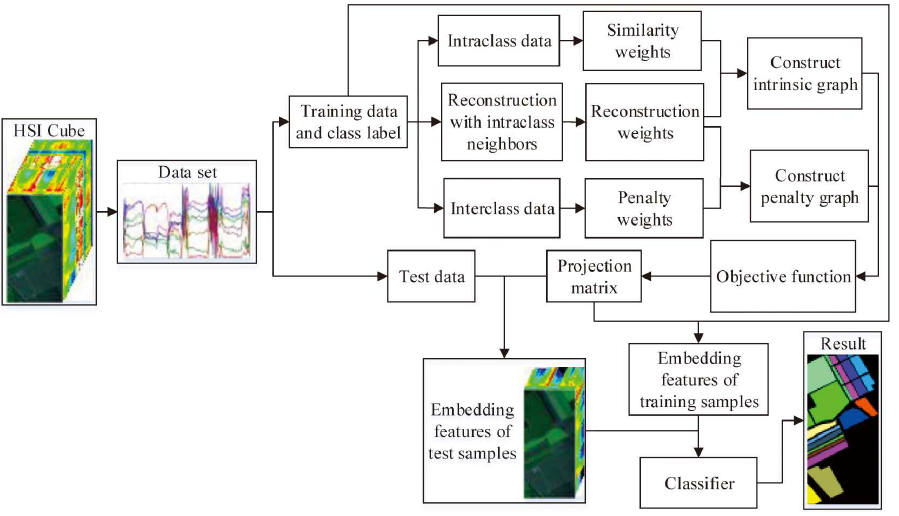
Figure 1. Process of the proposed LGSFA